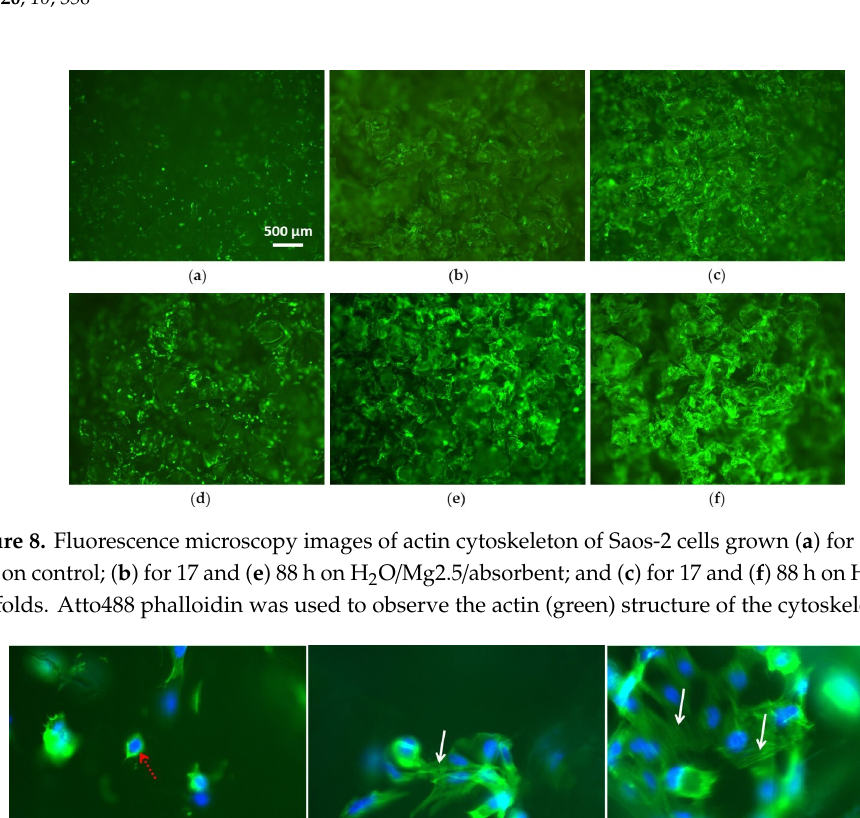
Figure 10. Fluorescence microscopy images of Saos-2 cells (88 h) on sections of ( a ) control, ( b ) H 2 O/Mg2.5/absorbent, and ( c ) H 2 /Mg15.8 scaffolds. Atto488 phalloidin was used to observe the actin cytoskeleton (green). 4. Conclusions Magnesium-containing coatings were deposited on PCL substrates using low-pressure RF sputtering of a MgO target in a properly configured plasma reactor fed with Ar, H 2 O, H 2 , or Ar/H 2 O as Ar/H 2 mixtures. XPS analyses and WCA measurements allowed assessment of the efficacy of the plasma processes, as well as investigation of their effects on the surface chemical composition and wettability of PCL samples as functions of the feed composition. The higher capacity of H 2 than H 2 O to sputter the MgO target to deposit magnesium-containing coatings and the creation of highly hydrophilic surfaces due to the use of H 2 O during plasma processes were demonstrated. The most marked differences were observed between substrates modified using H 2 O and H 2 as the feeds. Scaffolds treated with H 2 O were had the lowest magnesium content and were able to absorb water;